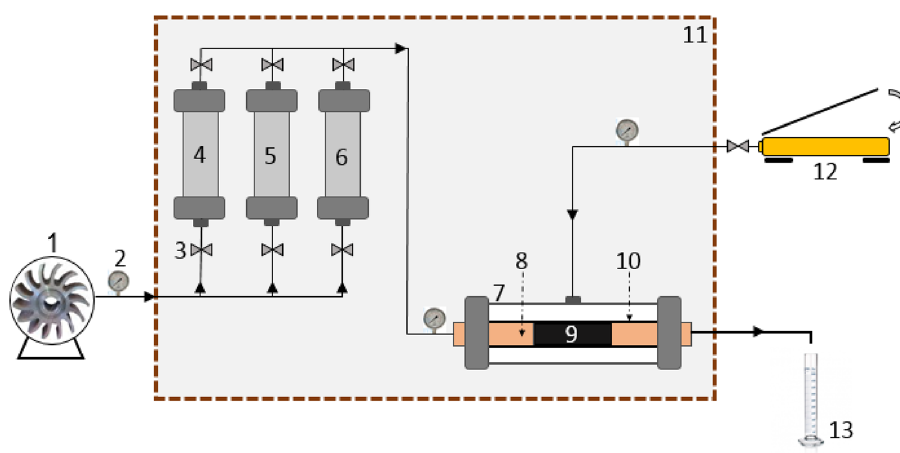
Fig. 3 Schematic of the